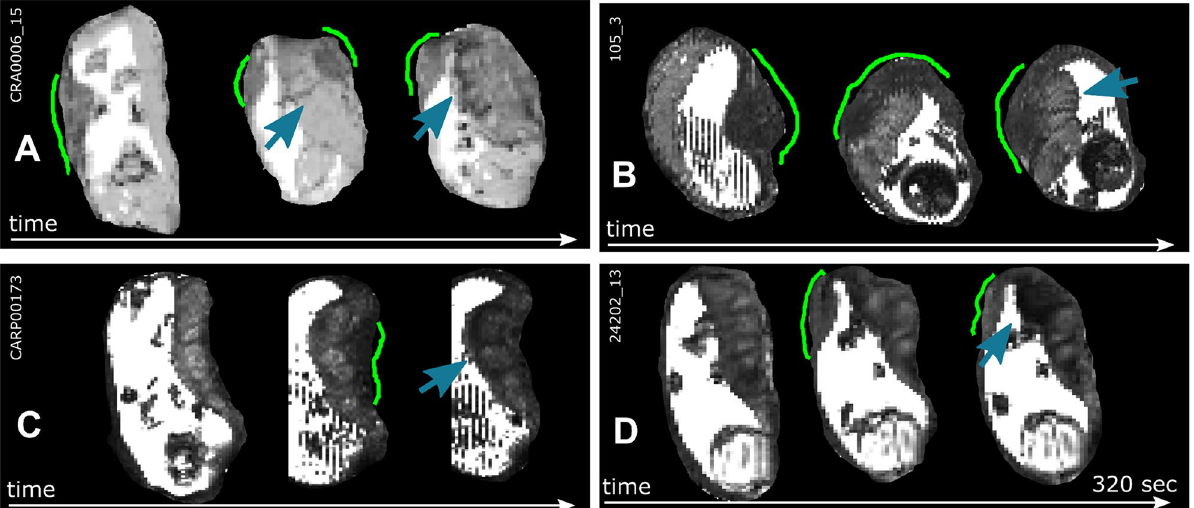
Figure 3. Dynamic time courses illustrating the different characteristics. T2* maps obtained at the same slice at different time points are displayed for subjects 15 ( A ), 2 ( B ), 4 ( C ) and 6 ( D ). Three dynamics over each scan are given in a sagittal direction to the mother, illustrating different phases before and during a uterine contraction. The area of the uterine wall contraction is labelled in green and the visible consequences in the placental T2* map (dark bands and a reduction in signal towards the chorionic plate) are highlighted with blue